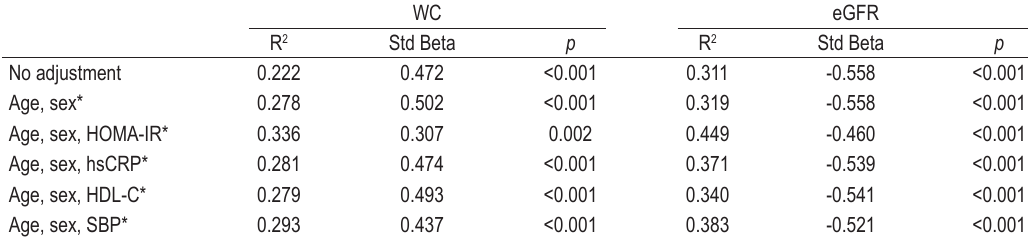
TABLE 3. Linear regression models with association between cystatin C and WC, and association between cystatin C and eGFR, independently in all